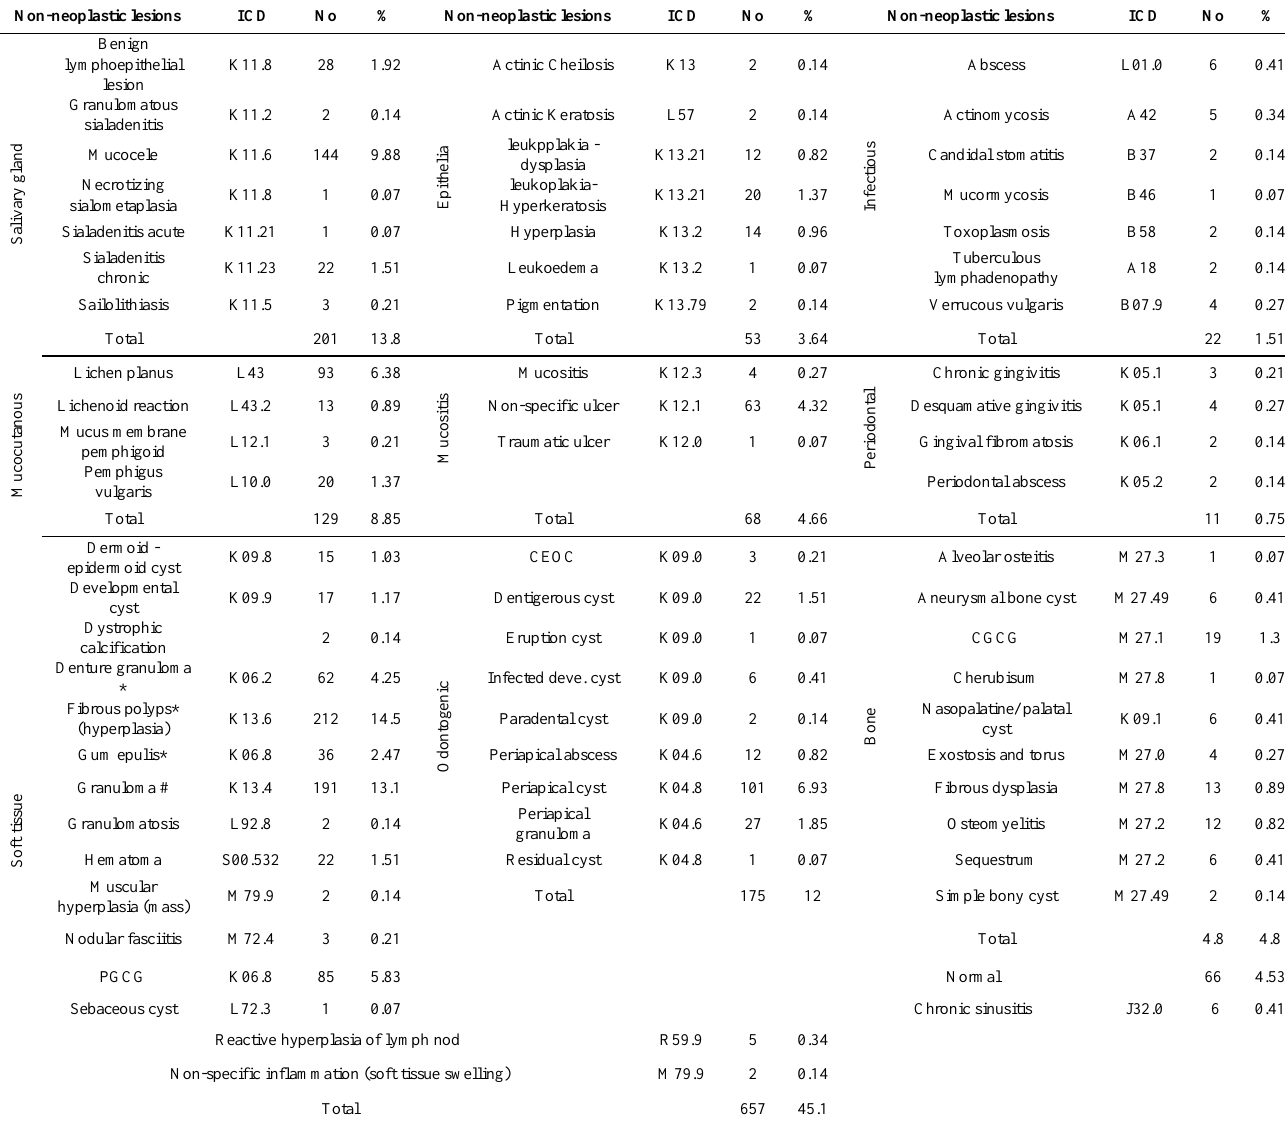
Table 4: Distribution of non-neoplastic oral and maxillofacial lesions. Non-neoplastic lesions Benign